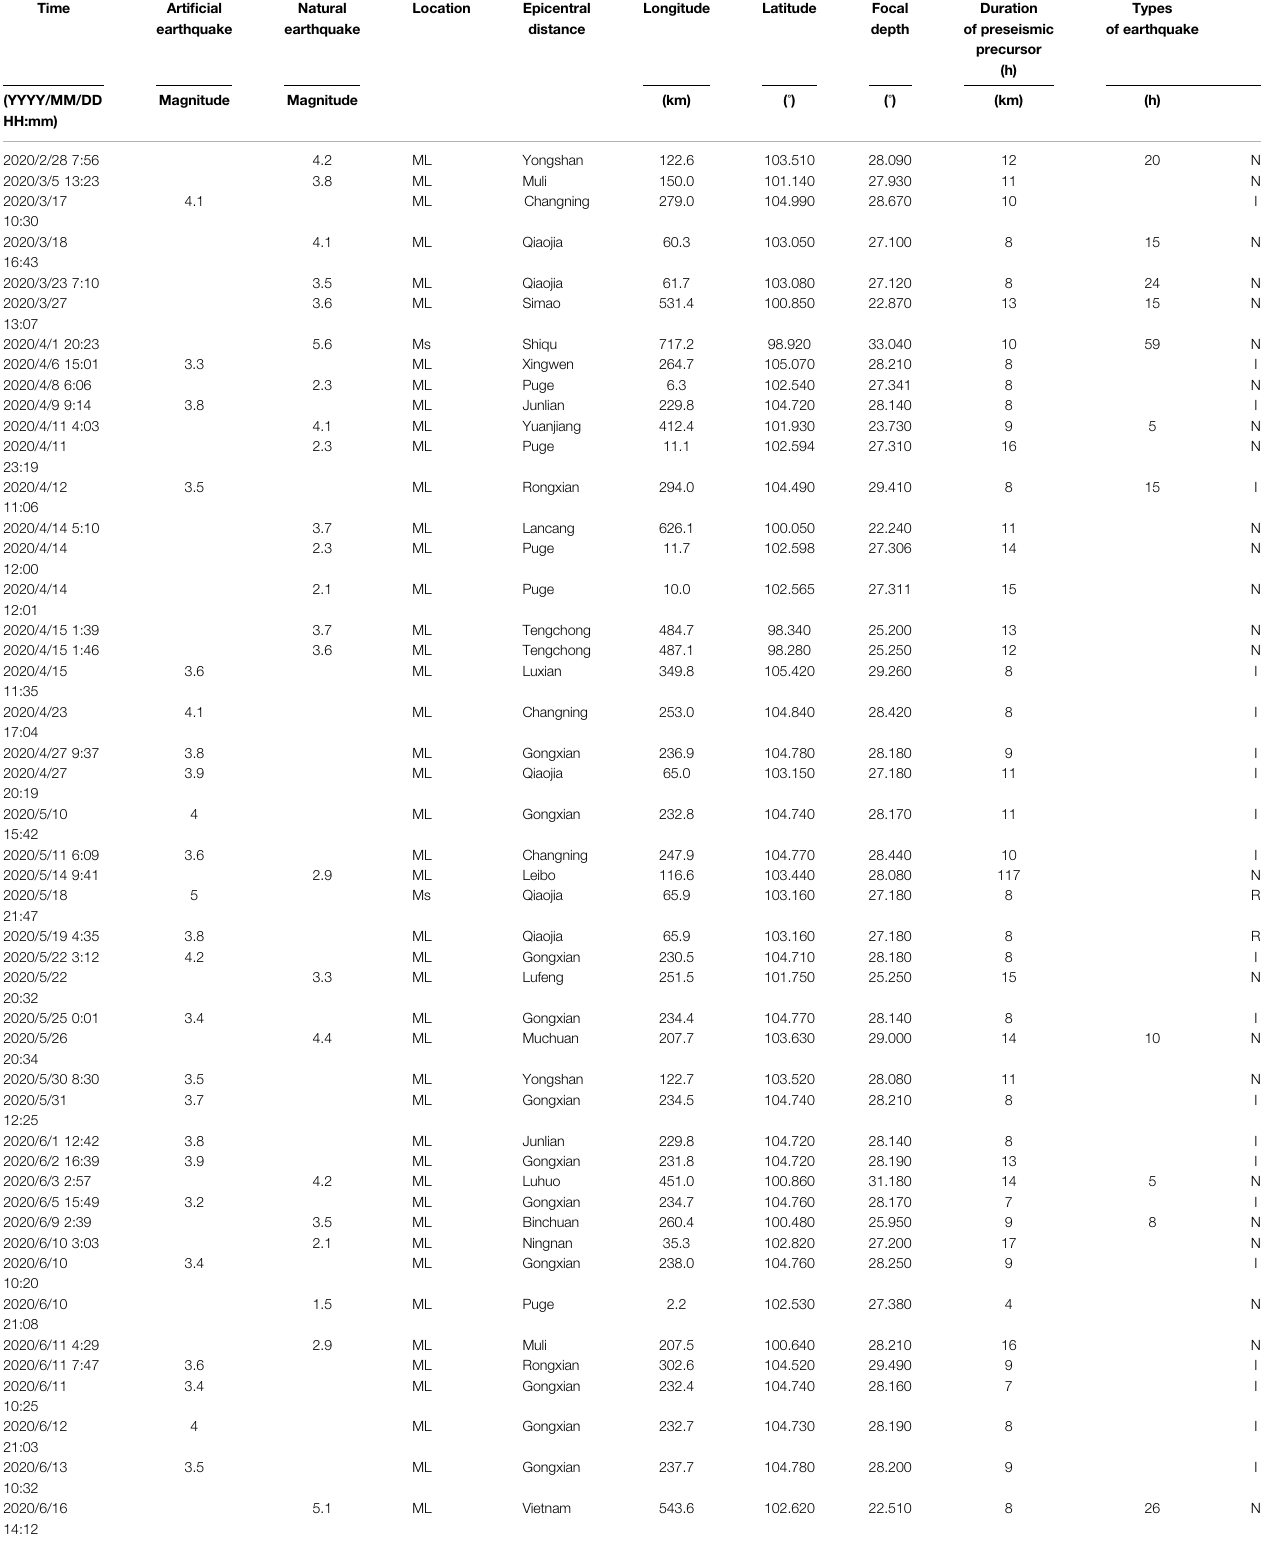
TABLE 2 | Seismic data is related to natural and arti fi cial earthquakes recorded during the course of monitoring. Time Arti fi cial